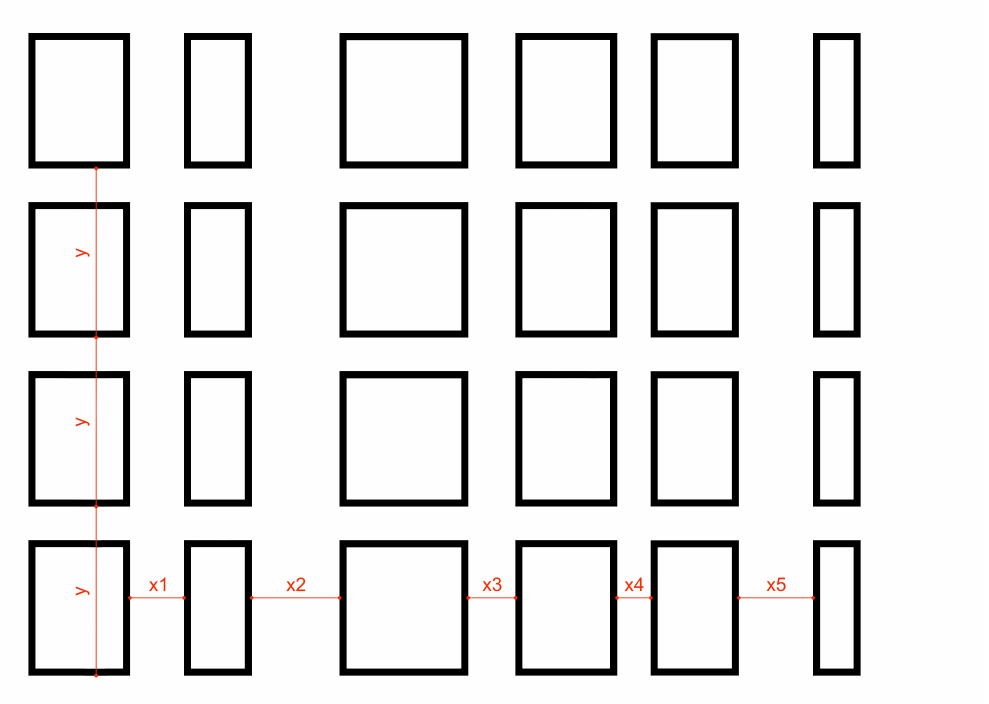
Figure 5. Diagram showing the assumptions of a “Y”